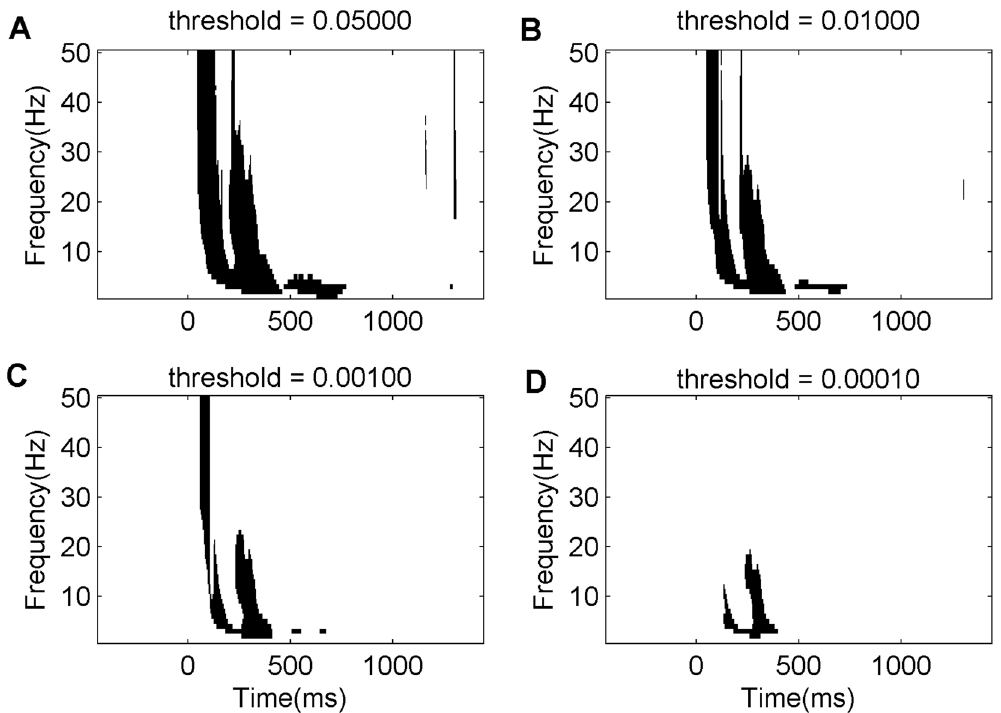
Figure 5. Illustration of Utility of Unbiased Cluster Estimation Technique. Panels A to D illustrate the impact of varying threshold statistic on the outcome of cluster estimation. The figure is adapted with permission from Frehlich et al . 17 . Data were collected from EEG channel CZ and compared statistically between two conditions. Y-axses represent frequency in Hertz and x-axes time in milliseconds with time 0 indicating application of a transcranial magnetic stimulation pulse. Each dark pixel denotes a voxel in the time-frequency space that